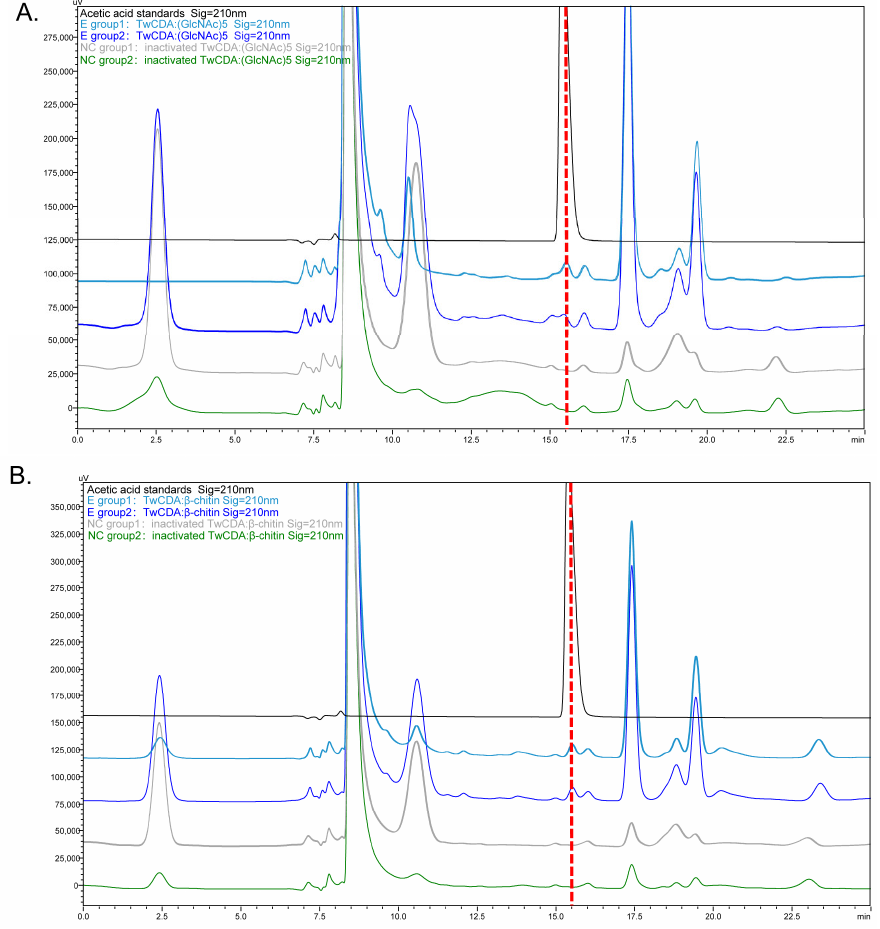
Figure 5. HPLC chromatograms presenting the deacetylation activity of TwCDA. ( A ) Chromatogram of TwCDA with (GlcNAc) 5 as substrate. ( B ) Chromatogram of TwCDA with β -chitin as substrate. The retention time of acetic acid standard was 15.389 min (black curves). Acetic acid was produced in both experimental groups (dark blue and light blue curves) but not in the control groups (gray and green curves).